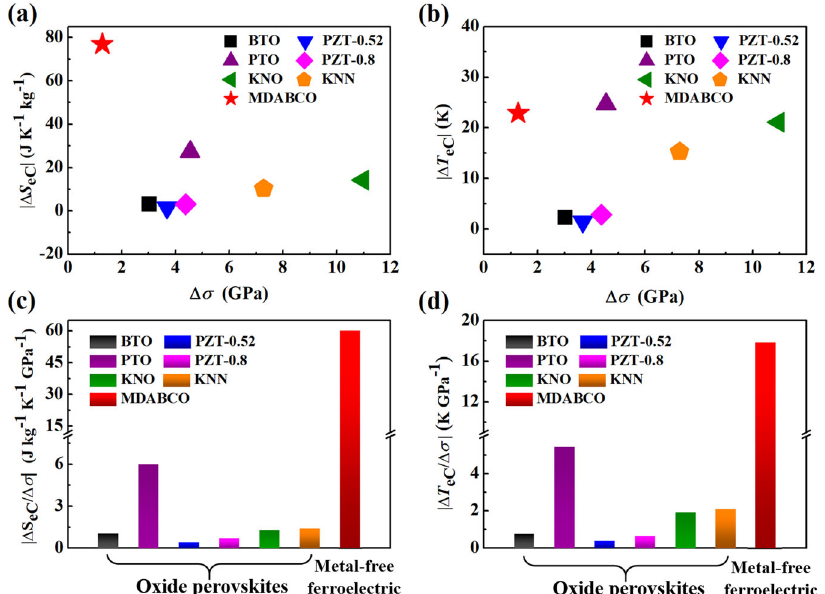
Fig. 5 Comparisons of the eC performance between [MDABCO](NH4)I3 and other ferroelectric thin fi lms from thermodynamic calculations. a The eC entropy change | Δ S eC |, b the eC temperature change | Δ T eC |, c the eC strength | Δ S eC / Δ σ |, and d the eC strength | Δ T eC / Δ σ